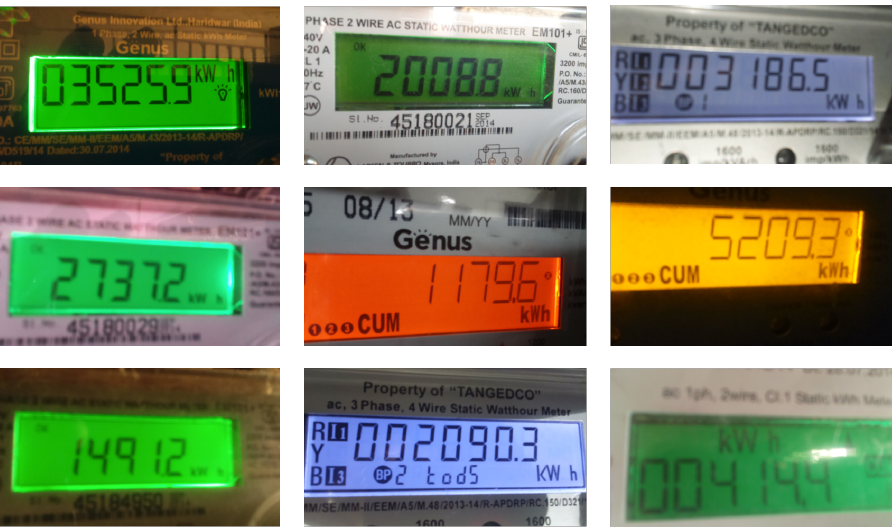
Figure 12. Some raw samples of our